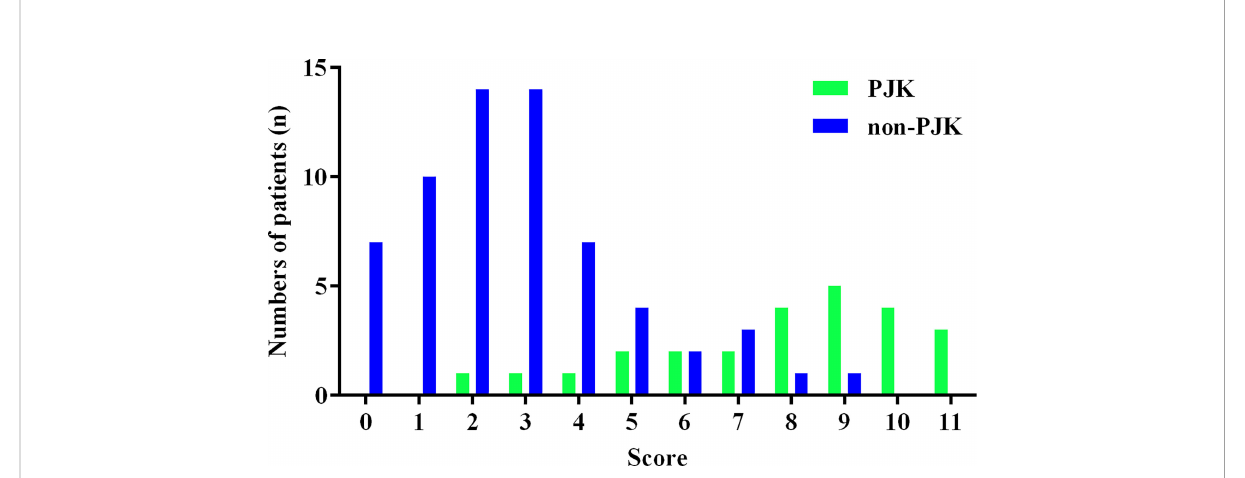
FIGURE 3 Histogram distribution of proximal junctional kyphosis (PJK) and non-PJK for each score of the predictive scoring